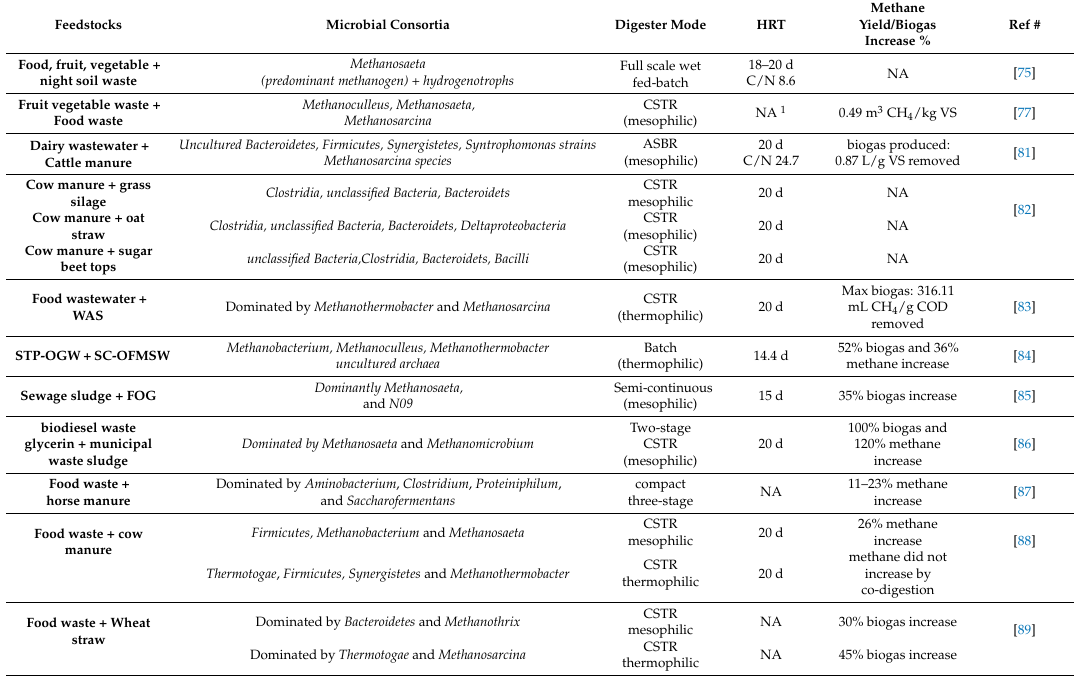
Table 2. The influence of using multi-feedstock in various AnCoD systems on microbial consortia diversity and biogas and biomethane